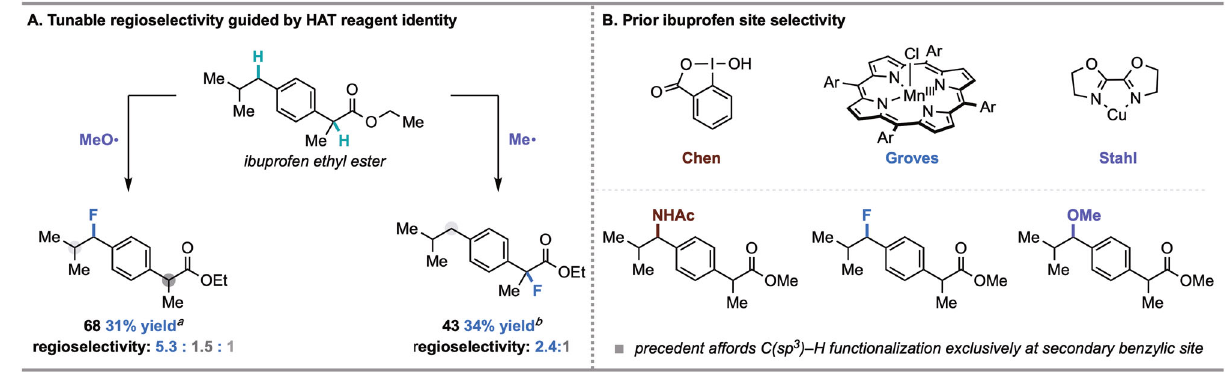
Fig. 6 Investigations of site-selectivity with methoxy and methyl radical in the functionalization of ibuprofen ethyl ester. A Tunable selectivity for the C(sp 3 ) – H functionalization of ibuprofen demonstrating favorable secondary benzylic fl uorination with methoxy radical (left) and favorable tertiary benzylic fl uorination with methyl radical (right). B Previous examples of site-selectivity in the C(sp 3 ) – H functionalization of ibuprofen 6,15,44 . a Reaction performed using abstractor 3 and standard reaction conditions described in Fig. 2. b Reaction performed using abstractor 1 and standard reaction conditions described in Fig.